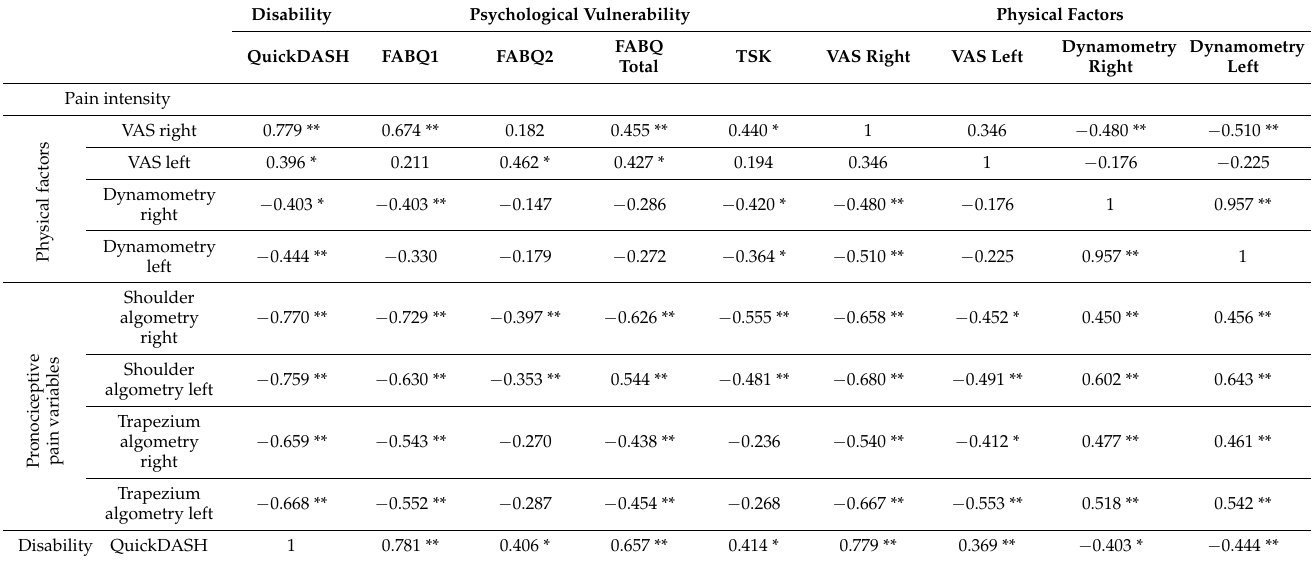
Table 3. Correlations between physical factors, pronociceptive pain variables, psychological measures and